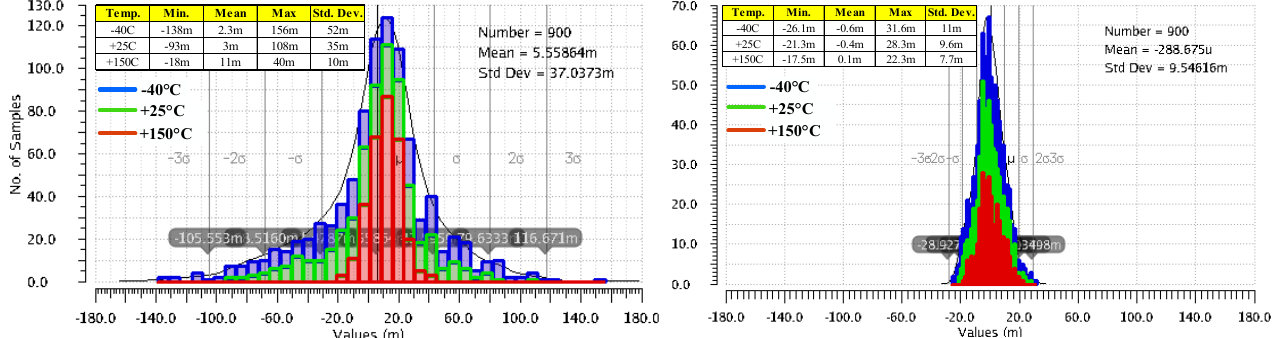
Figure 12. Deviation caused by component mismatches of the LDO output voltage from its nominal DC value for the LDO reported in [10] ( left ) and the proposed LDO, shown in Figure 3 ( right ). Results of 300 Monte Carlo simulation runs for three temperatures, − 40 °C, +25 °C, and +150 °C, and constant line voltage and loading: VIN = 1.5 V, IL = 1 mA, and CL = 100 pF. The common gate error amplifier used in [10] is fast but exhibits a large output voltage offset: the mean value is 5.5 mV and the standard deviation is very large at 37 mV. The composite OTA added to the LDO shown in Figure 3 ensures a significantly better accuracy: a mean value of 288 μ V and a standard deviation of only 9.5 mV, that is, 3.8 times smaller than the